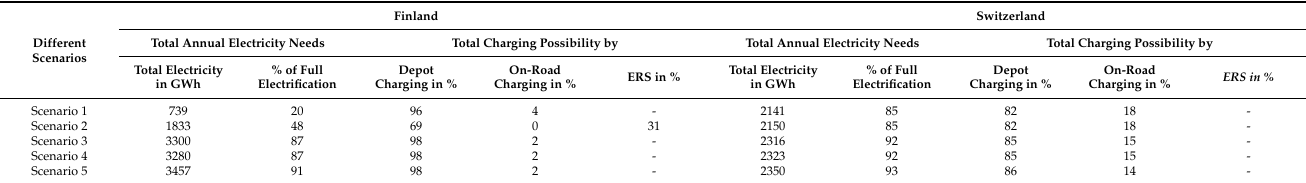
Table 7. Summary results for the power grid load requirement